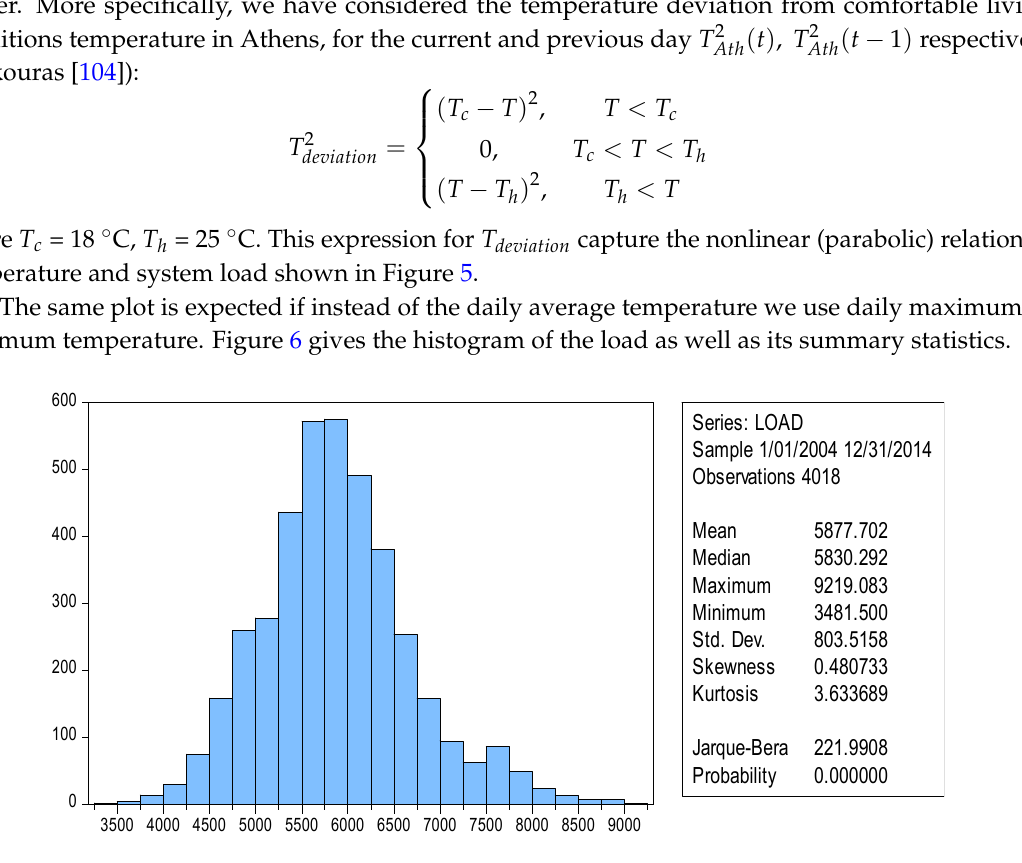
Figure 6. Histogram of load time series, summary statistics and Jarque ‐ Bera test results.